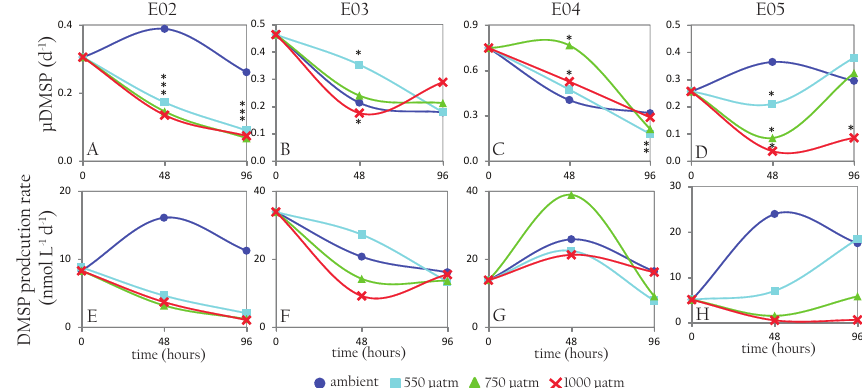
Figure 4. De novo synthesis of DMSP ( µ DMSP, d − 1 ) (a–d) and DMSP production rates (nmolL − 1 d − 1 ) (e–h) for E02–E05 (data not avail- able for E01). Asterisks (*) denote significant differences from ambient CO 2 bioassays (significance of F ratio from ANCOVA, p <0.05). Smoothed lines on plots do not represent extrapolation of data between time point measurements but are used to highlight trends.